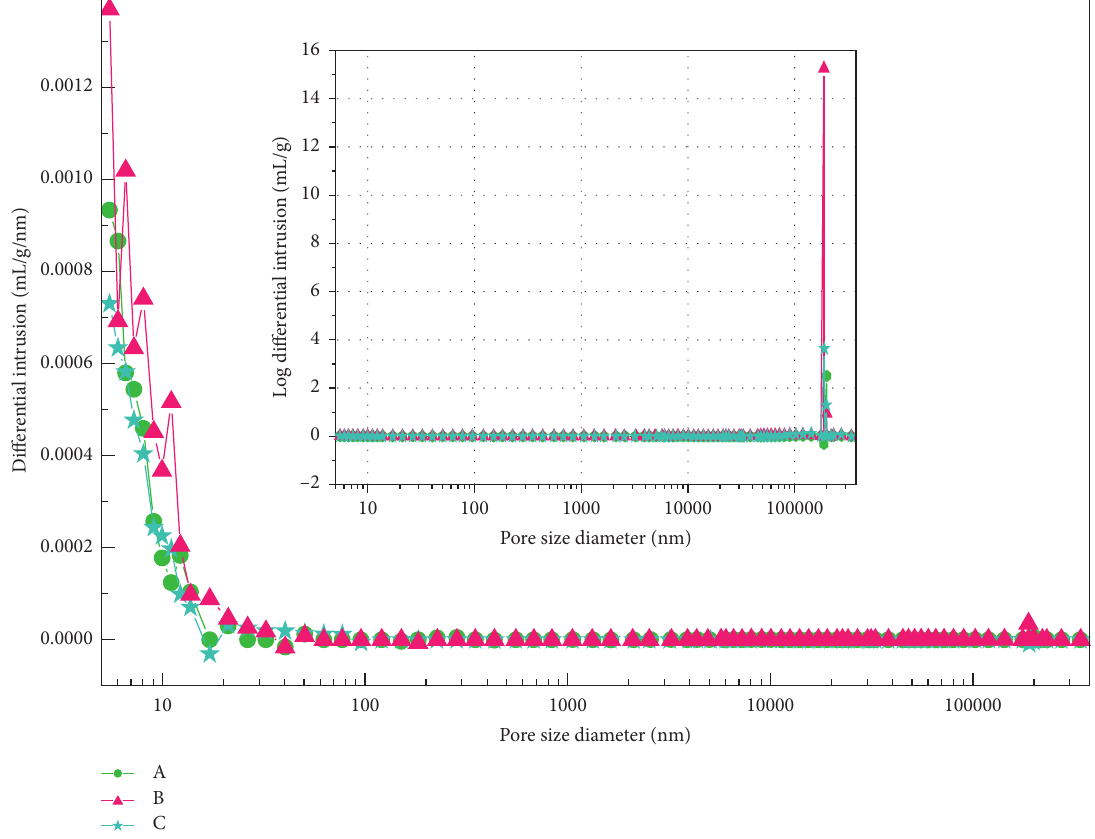
Figure 10: Differential intrusion and logarithmic differential intrusion of mercury in coal samples: (A) raw coal; (B) coal after heat action; (C) coal with static blasting material after heat action.